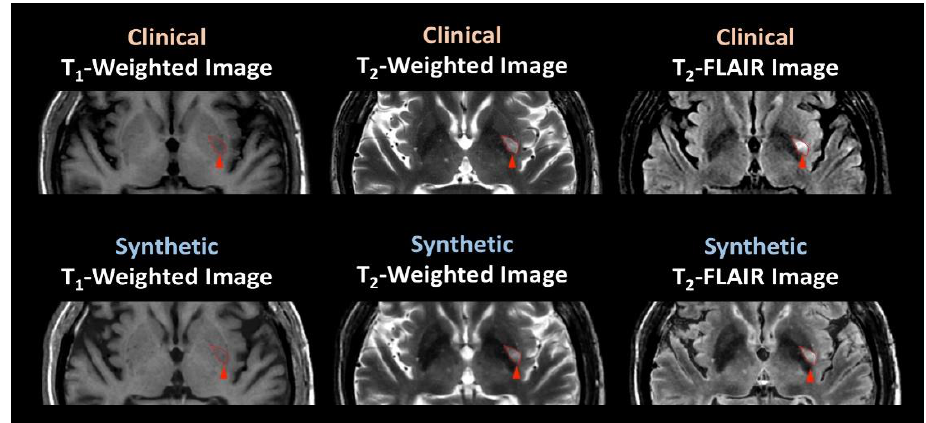
Figure 4. Images acquired by clinical and synthetic scanning of a 64-year-old male patient with stroke.